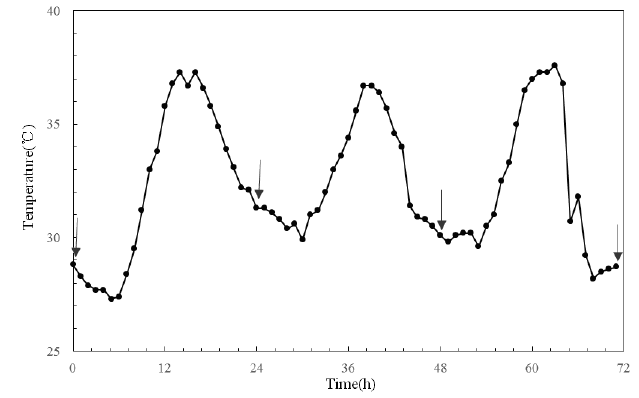
Figure 1. Temperature curve of simulated heat wave. The arrows stand for sampling time points when body temperature and body weight of ApoE-/- mice were measured in the three experimental